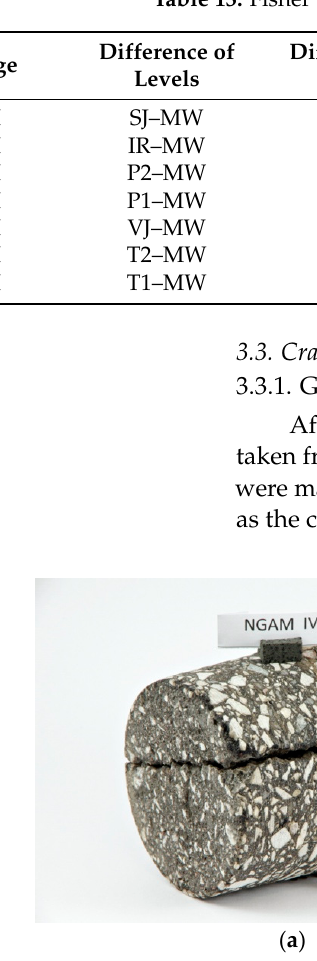
Figure 12. Compaction degree test results of specimens taken from longitudinal joints. Table 13. Fisher’s pairwise comparison for density test, bulk density SSD, Mg/m 3 .